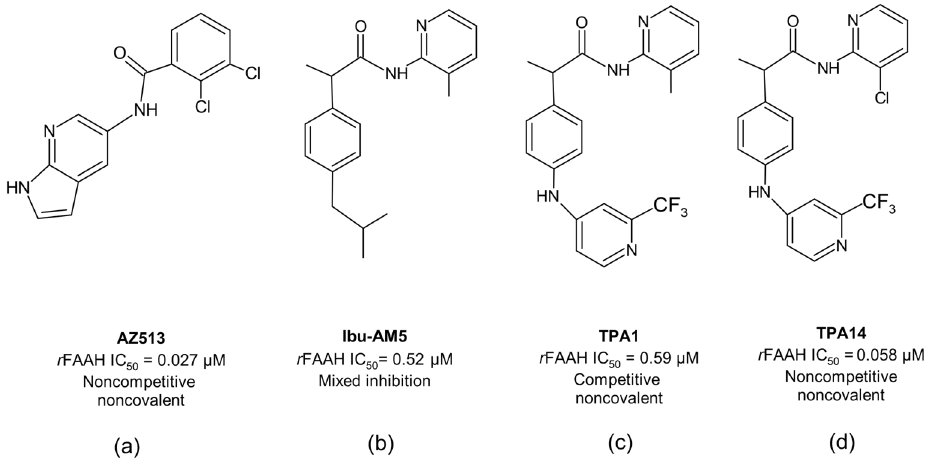
Figure 2. The 2D structures of: ( a ) AZ513; ( b ) Ibu ‐ AM5; ( c ) TPA1 and ( d ) TPA14.